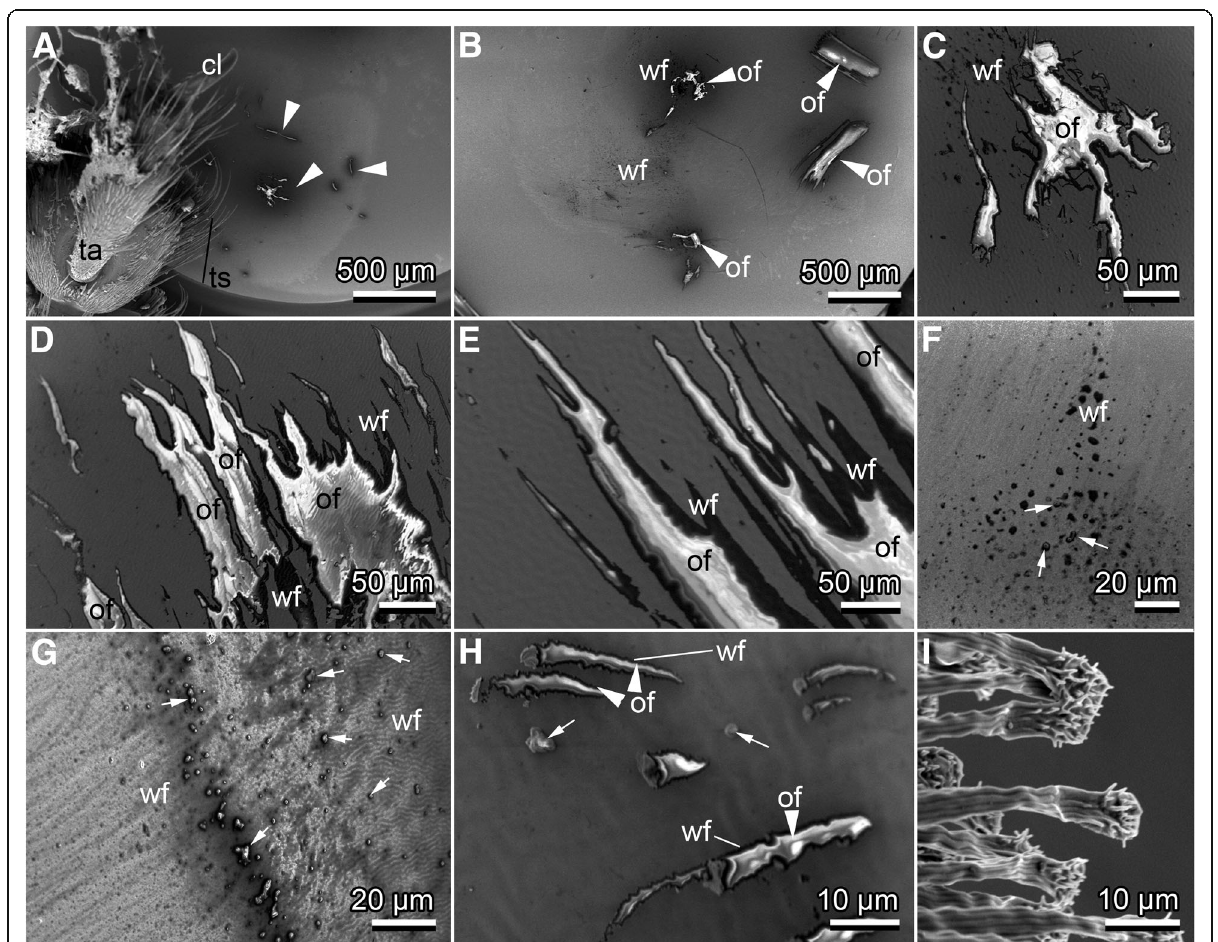
Fig. 3 Footprints left by tarsal setae of Monochamus alternatus after bringing them in contact with and subsequently remove them from a gold- covered resin surface visualized by cryo-SEM; male ( a , b , d , e , h , i ); female ( c , d , f , g .). a . 3rd to 5th tarsomeres close to their print on the surface from where they were detached during freezing and vacuum procedure. b – h . Residues of footprints. i . Terminal adhesive setae on a male foreleg ’ s tarsus for comparison with the dimension of footprints ( a - h ). cl, claw; ta, tarsus; ts, tactile setae; wf, presumably watery fluid; of, presumably oily fluid; arrows indicate contamination with wood particles; arrow heads point to oily fluid residues